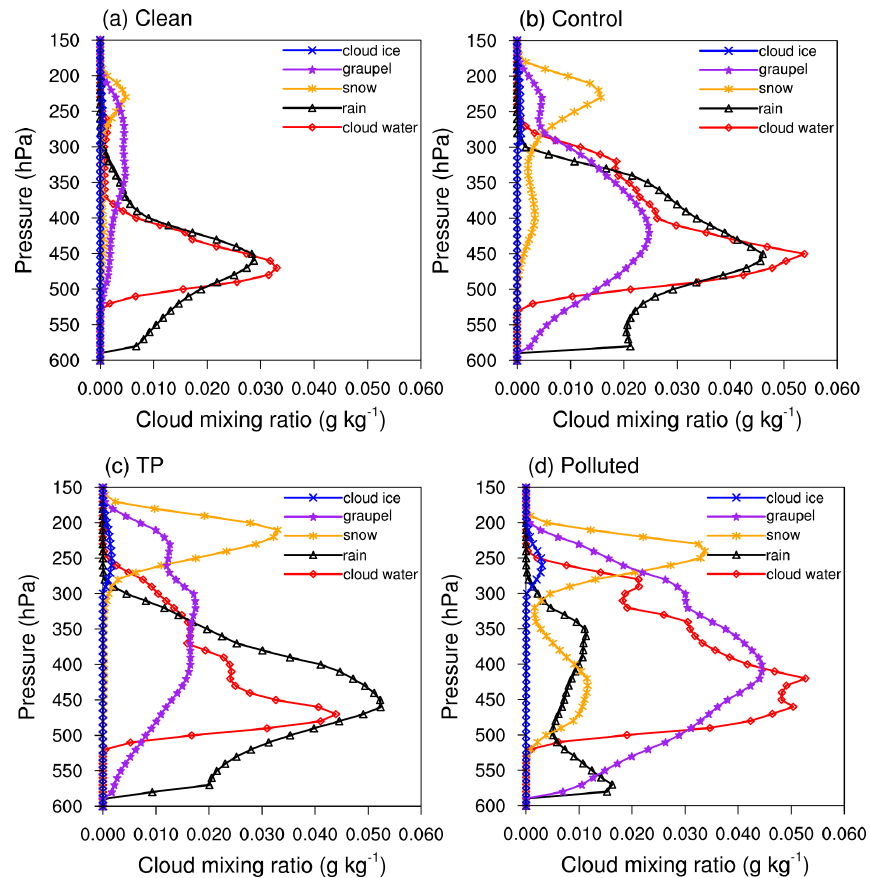
Figure 7. Mean water condensate mixing ratio as a function of height for (a) clean, (b) control, (c) TP, and (d) polluted cases in area A (31.4–31.5 ◦ N, 92.0–92.1 ◦ E) from 06:00 to 11:00UTC on 24 July 2014; units: gkg − 1 .